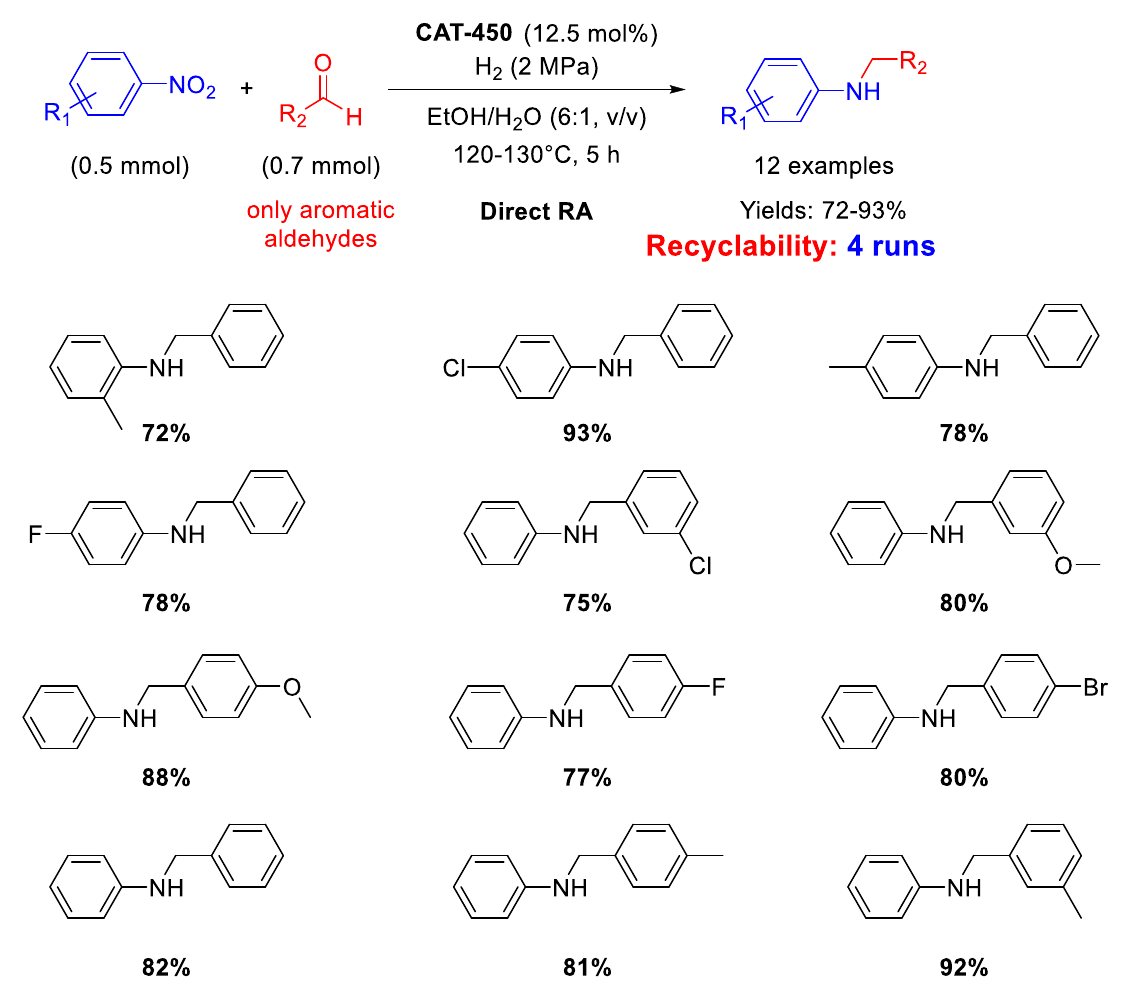
Scheme 53. DRA catalyzed by